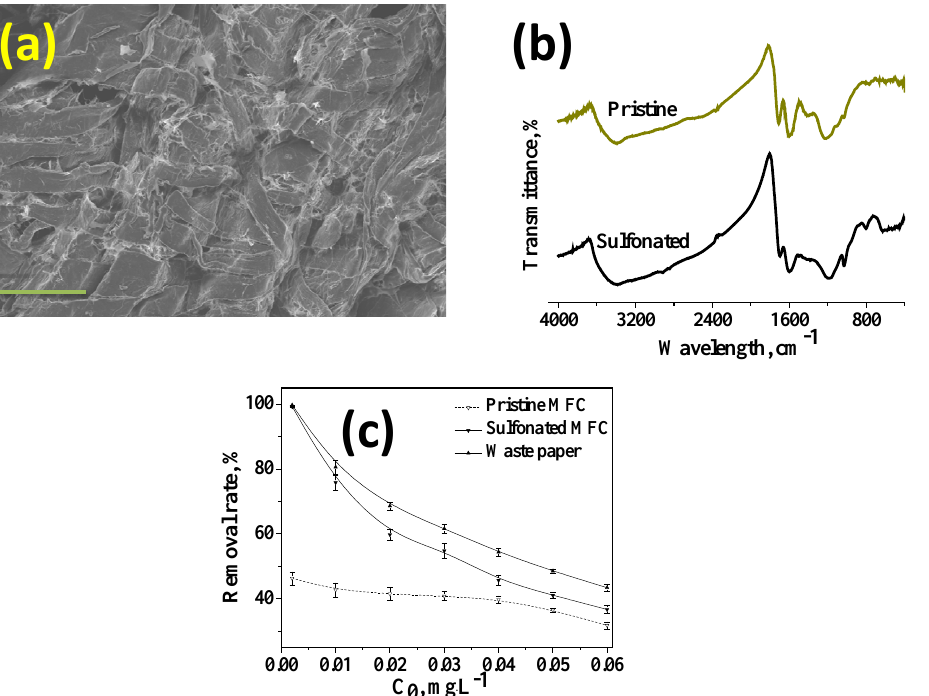
Figure 4. Representative SEM micrograph of sulfonated microfibrillar cellulose ( a ), FTIR spectra of pristine and sulfonated microfibrillar cellulose ( b ), and removal rate of Pb(II) at pH = 5.5 on pristine, sulfonated microfibrillar cellulose, and waste paper at various concentrations of Pb(II) ( c